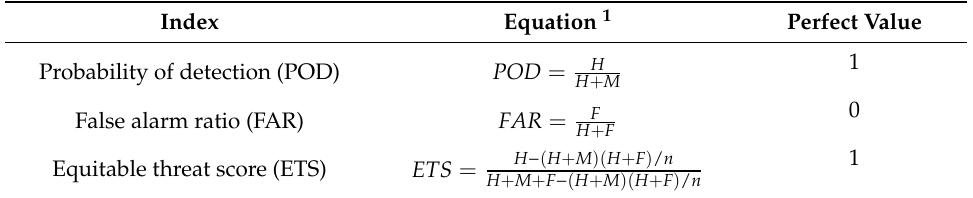
Table 2. Equations and the best values of three contingency statistical indices.